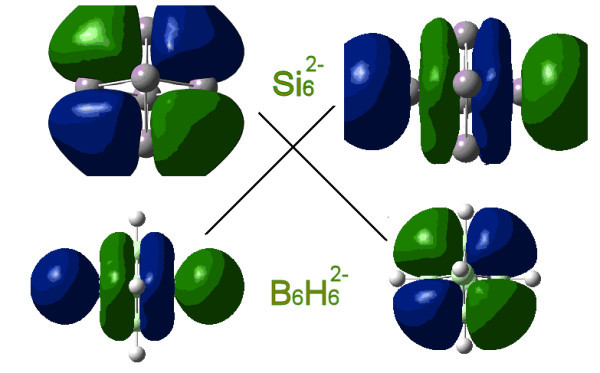
Schematic illustration of the original boron connection between dianions. Isolobal analogy of Si62- dianion and the B6H62- borane.